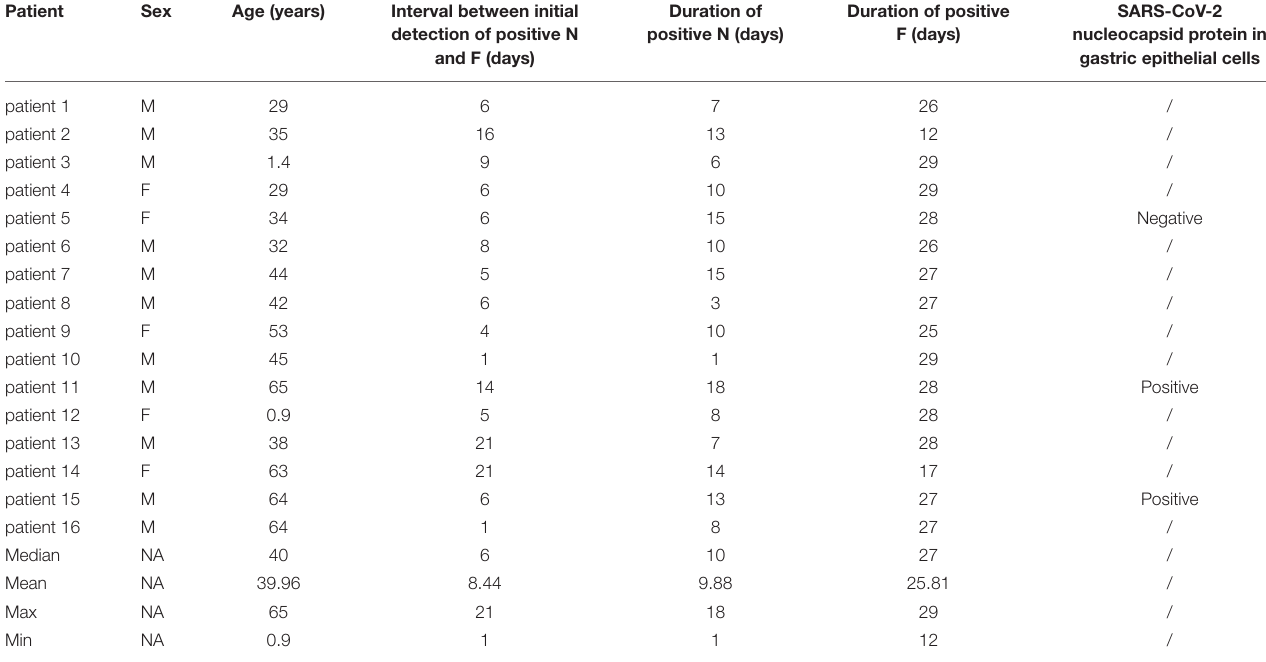
detection of positive N